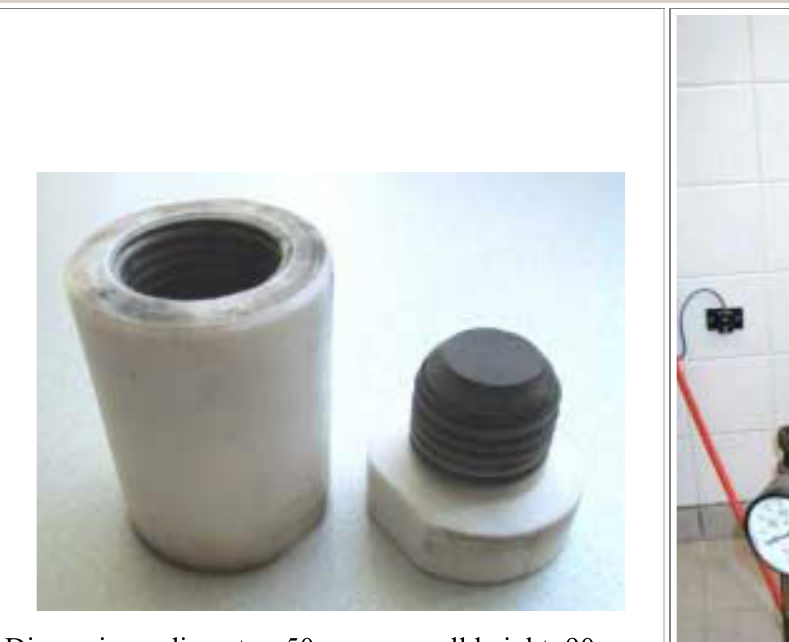
Dimensions: diameter: 50 mm, overall height: 90 mm, inside volume: 9 mL